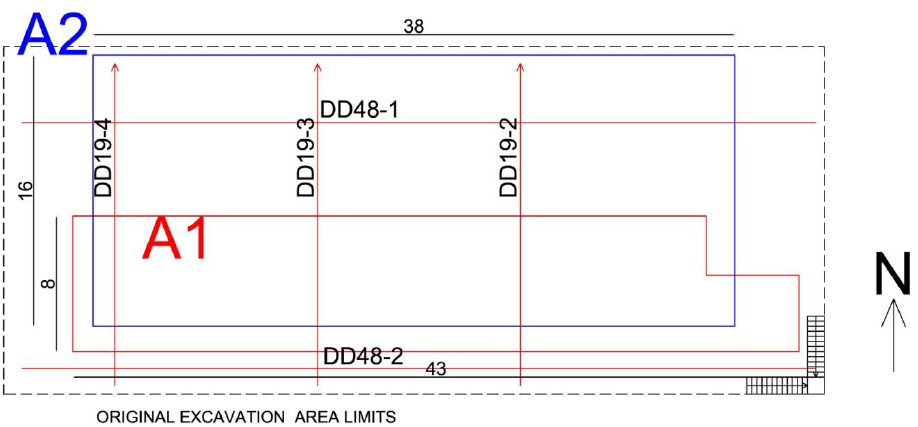
Figure 3. Area analyzed with GPR coupled to 200–600 MHz array ( A2 ) and 100 MHz antenna ( A1 ) and localization of ERTs acquisitions (DD19-2, DD19-3, DD19-4, DD48-1, DD48-2).